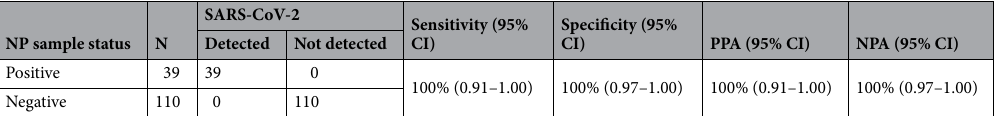
Table 3. Clinical NP/OP swab evaluation of EM Kit compared to DiaCarta QuantiVirus™ Real-time PCR coronavirus (SARS-CoV-2) detection kit. SARS-CoV-2 RNA was extracted from swab samples using the Qiagen QIAamp™ Viral RNA mini kit with eluates split and frozen at − 80 °C. Aliquots were then tested with both amplification